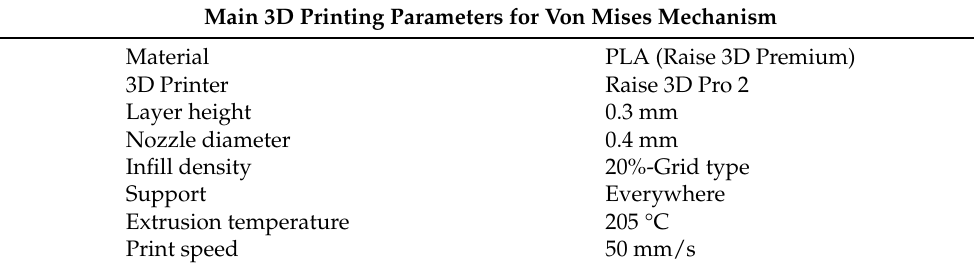
Table 2. Main 3D printing parameters for Von Mises